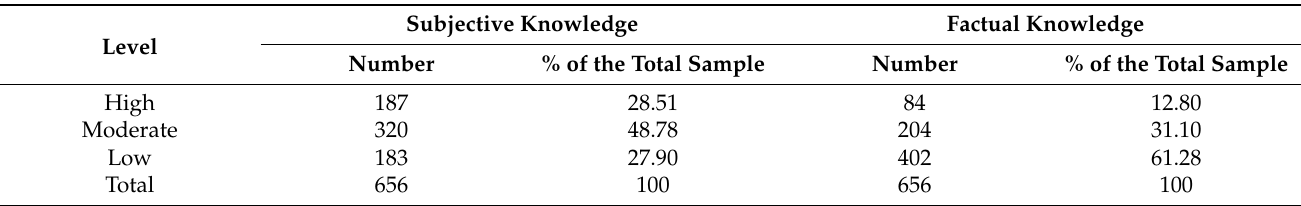
Table 7. Number and percent of survey respondents and level of subjective and factual knowledge based on respondent’s confidence in identifying wild birds, support for conservation, and agreement with scientific facts about bird ecology.